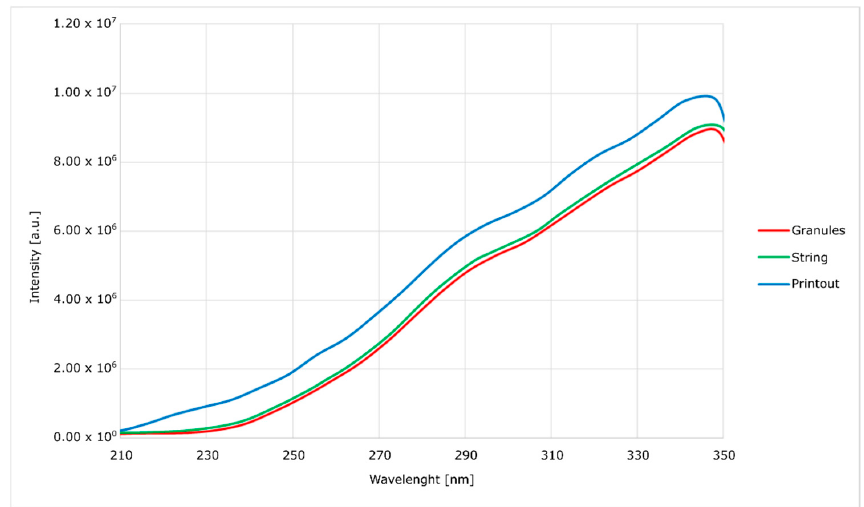
Figure 8. Excitation spectra of nanosilver-modified PC .